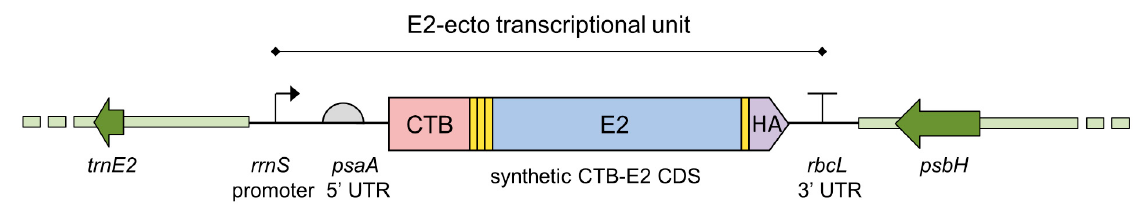
Figure 1. Illustration of the E2-ecto transgene inserted in the C. reinhardtii plastome. The four level 0 parts (promoter, 5 ′ UTR, CDS and 3 ′ UTR) were assembled to form the level 1 transcription unit, which was targeted to a neutral site between psbH and trnE2 in the plastome of the psbH -deletion mutant TN72, with transformants selected based on restoration of PsbH function, as described by Wannathong et al. [22]. The coding sequence encodes a 511-residue chimeric protein comprising the cholera toxin beta (CTB) subunit, three copies of a GGGGS linker, the SAV E2 ectodomain (E2), a single copy of GGGGS and the HA epitope tag.